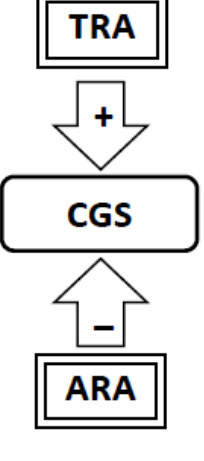
from the persistent tolerance-related adaptations (Figure 7). Figure 7. After smoking cessation, the brain dismantles the Withdrawal-Related Adaptations but is unable to dismantle the Tolerance-Related Adaptations (TRA). Unless something is done to re-establish homeostasis, craving would continue forever. To restore homeostasis, Abstinence-Related Adaptations (ARA) develop to provide inhibitory input to the Craving Generation System (CGS) counter-balancing the stimulatory input from the TRA. At this point, withdrawal-related craving ends, but craving could still be stimulated by smoking or emotional